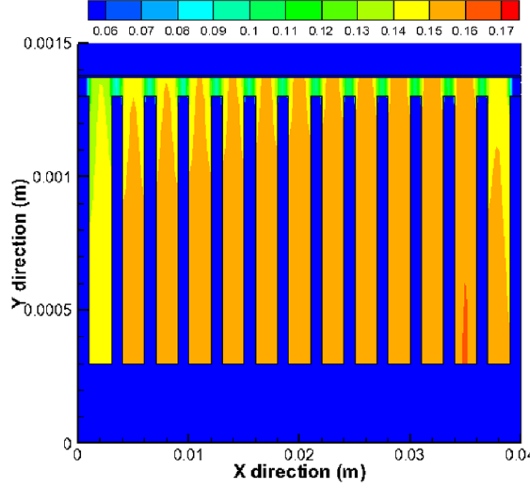
for a cross-section in the plane z = 0.03 m (not in scale). 2